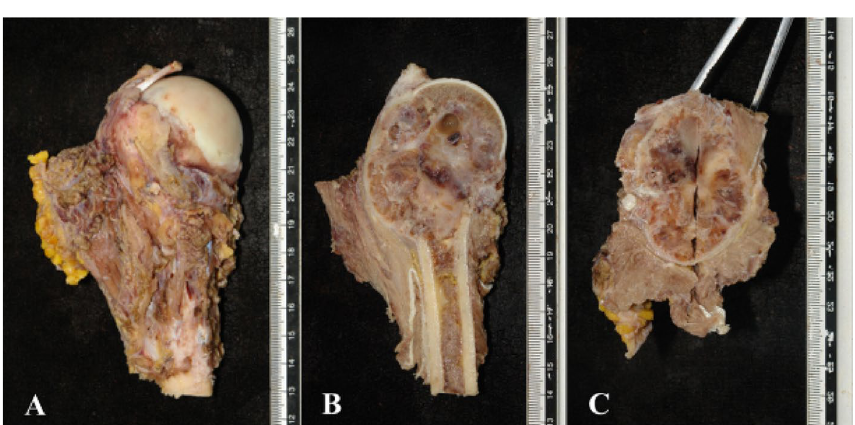
Figure 4. The postoperative specimen was soaked in formalin and then photographed ( A ). The specimen was cut along the longitudinal ( B ) and transverse ( C ) lines to analyze whether the safe surgical margin and osteotomy length were achieved.